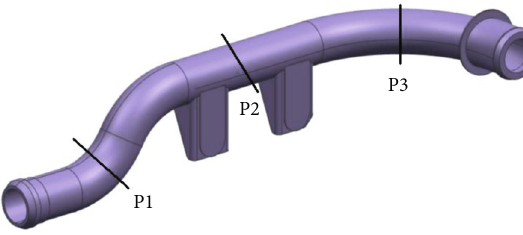
Figure 3: Model of cooling water pipe.